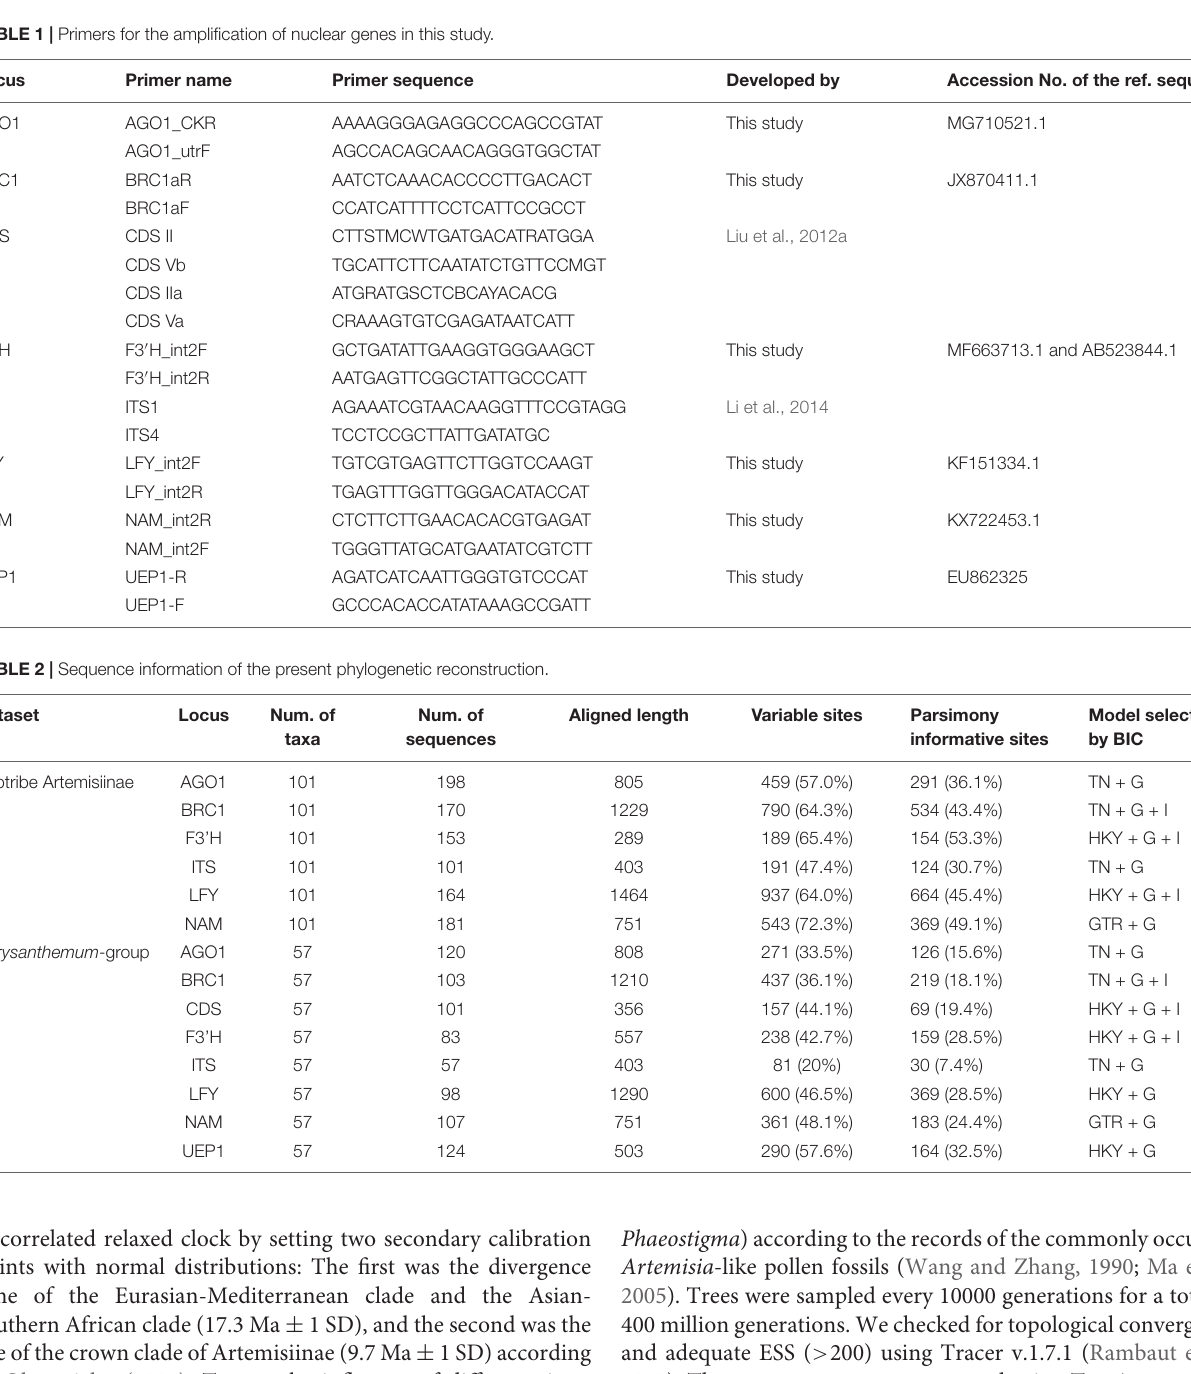
TABLE 1 | Primers for the amplification of nuclear genes in this study. Locus Primer name Primer sequence Developed by Accession No. of the ref. sequence